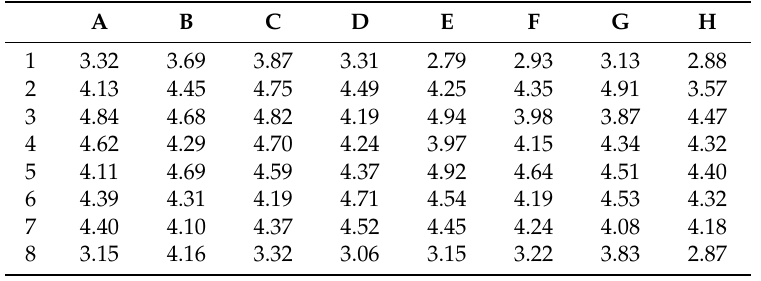
Table A10. Measured values of air velocity distribution in Experiment A4